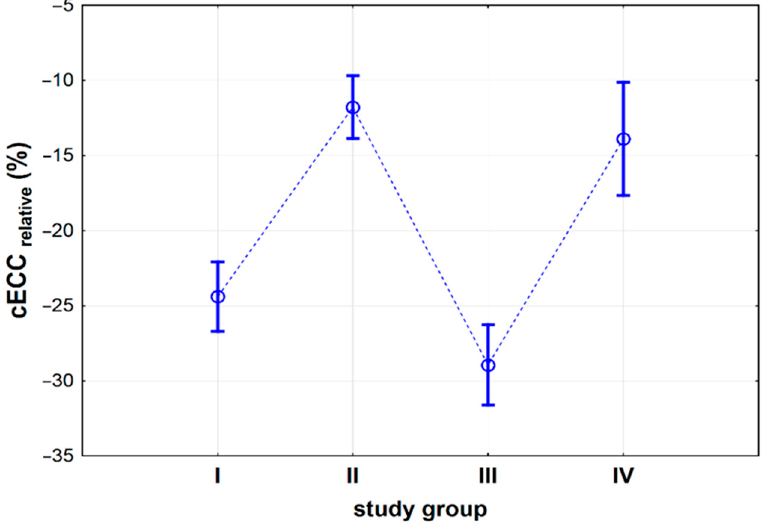
Figure 5. Relative corneal endothelium cell count (cECC relative ) (%) in four groups of patients sub- jected to iris-claw Artisan intraocular lens (IOL) implantation: I—patients subjected to complicated cataract surgery, II—patients with postoperative aphakia, III—patients with aphakia subjected to penetrating keratoplasty, IV—patients subjected to pars plana vitrectomy and luxated IOL extraction. Vertical lines represent 95% confidence intervals. For the convenience of the reader, the dots are connected by a dashed line.